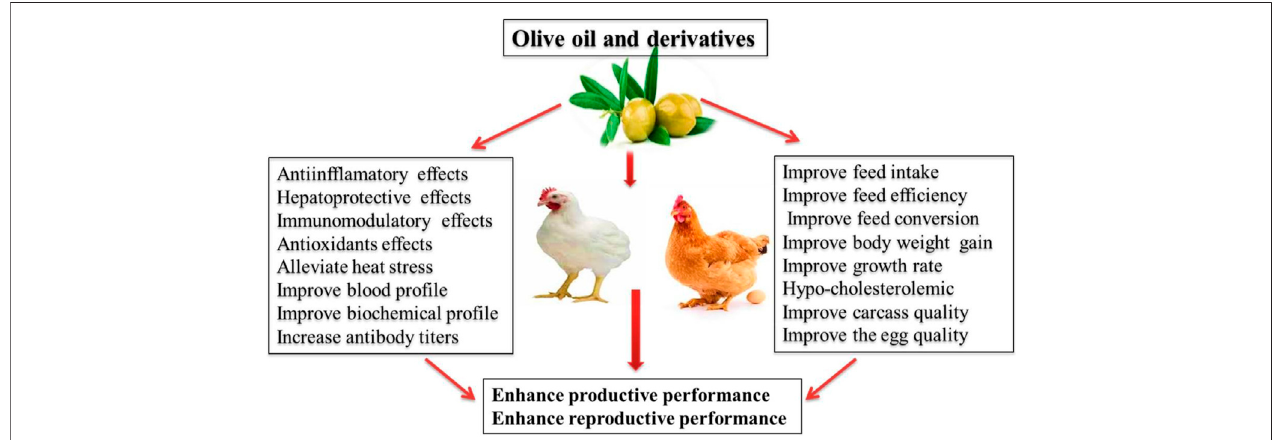
FIGURE 2 | Application of olive oil and derivatives in poultry